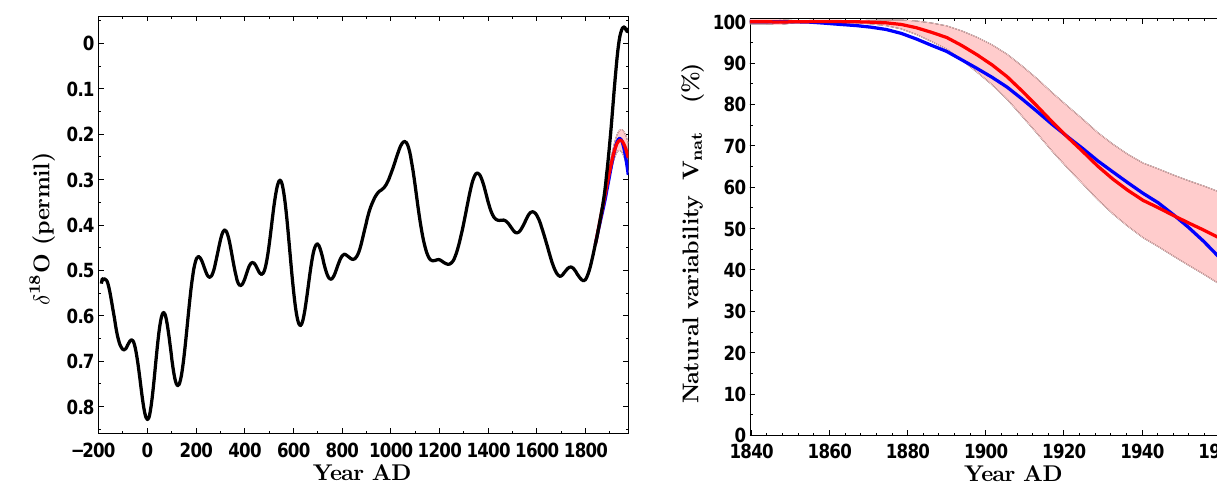
Fig. 7. Fraction V nat (t) of natural variability in the δ 18 O series for the Industrial Era. Red curve: for the SSA-AR method, with pink shading for the corresponding error belt; and blue curve: for the neural-network prediction. Both are calculated according to Eq. (3) and shown as percentages.